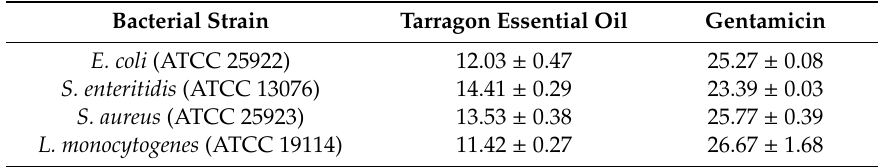
Table 2. Diameters of inhibition zones (mm) of bacterial strains produced by the tarragon essential oil and